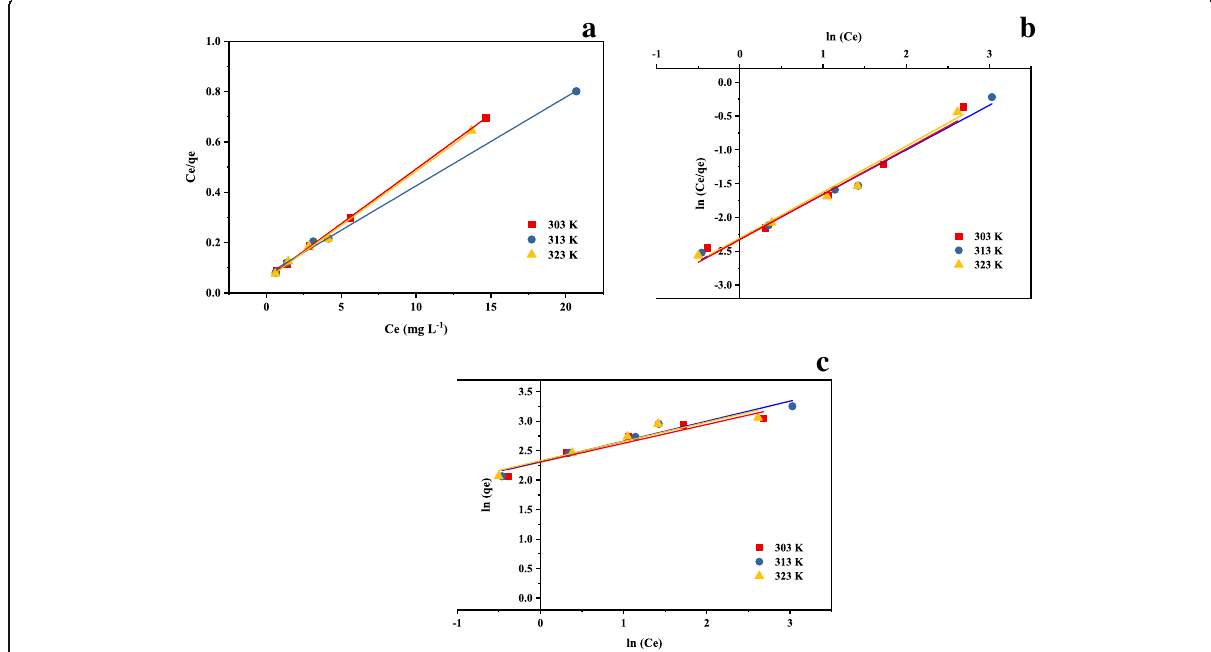
Fig. 5 Isotherm plots for adsorption of RB-21 on MMCC ( a ) Langmuir isotherm ( b ) Freundlich isotherm and ( c ) Redlich-Peterson isotherm